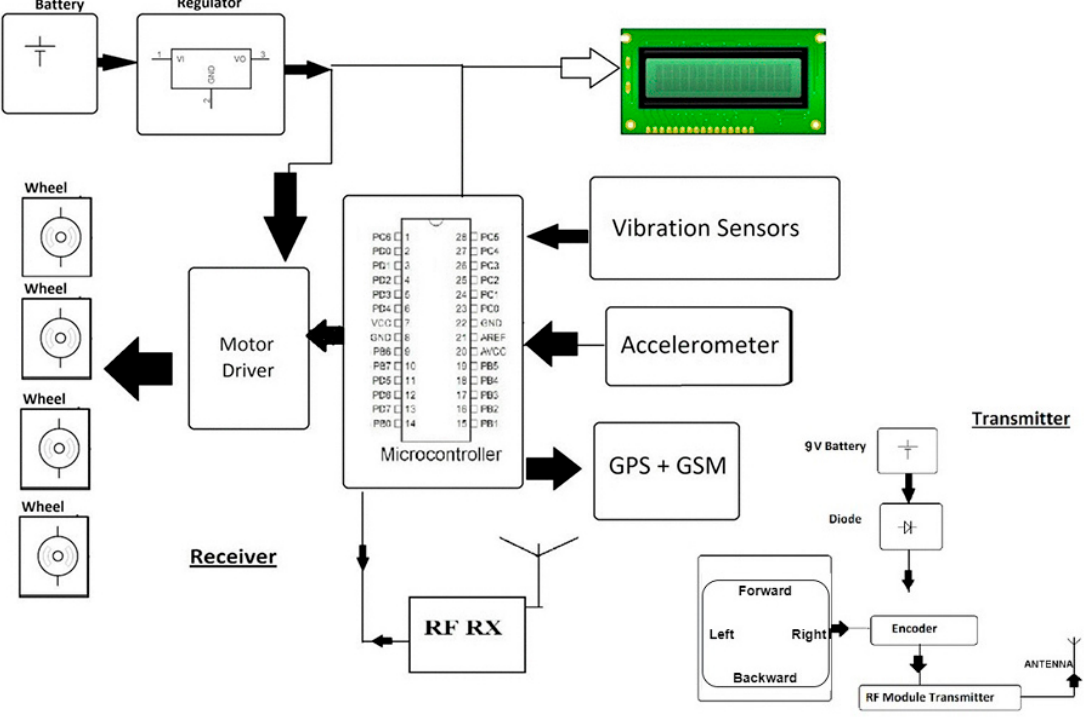
Figure 3. Circuit diagram of the proposed hardware for road safety.